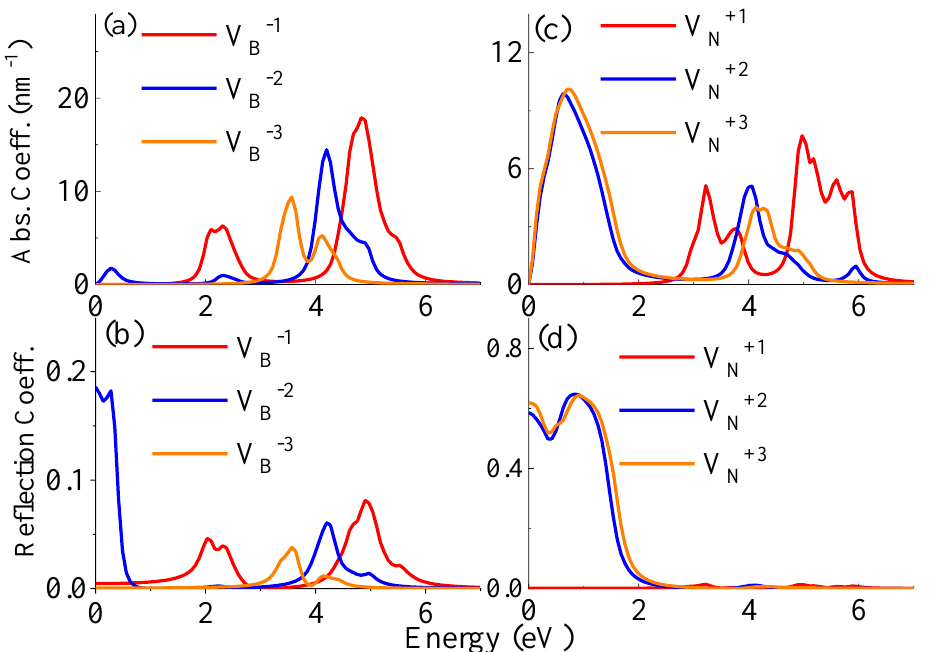
Figure 8. Optical spectra of hBN monolayer with charged defects. ( a ) Absorption and ( b ) reflection spectra of hBN supercell with various charged defects of V B −1 , V B −2 , and V B −3 ( c ) absorption and ( d ) reflection spectra of hBN supercell with various charged defects of V N+1 , V N+2 , and V N+3 .